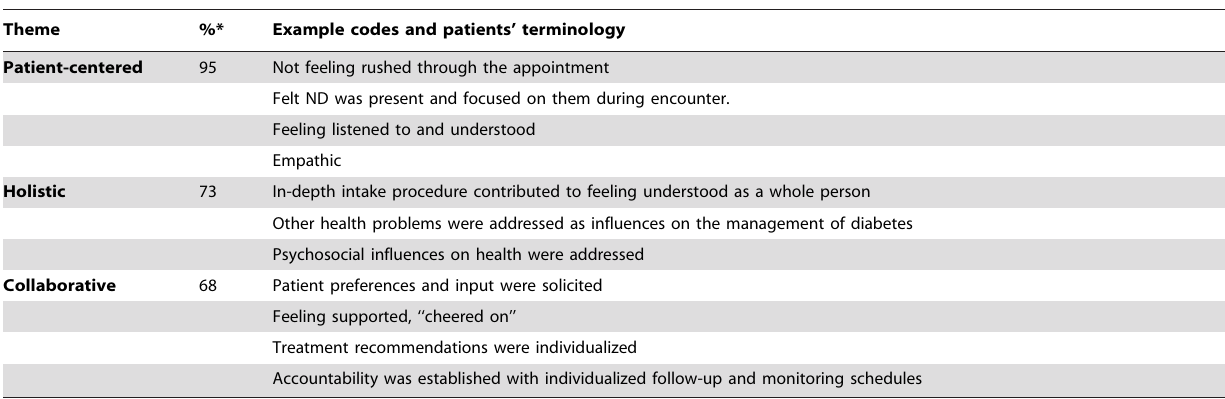
Table 3. Themes related to the nature of naturopathic care (n= 22).